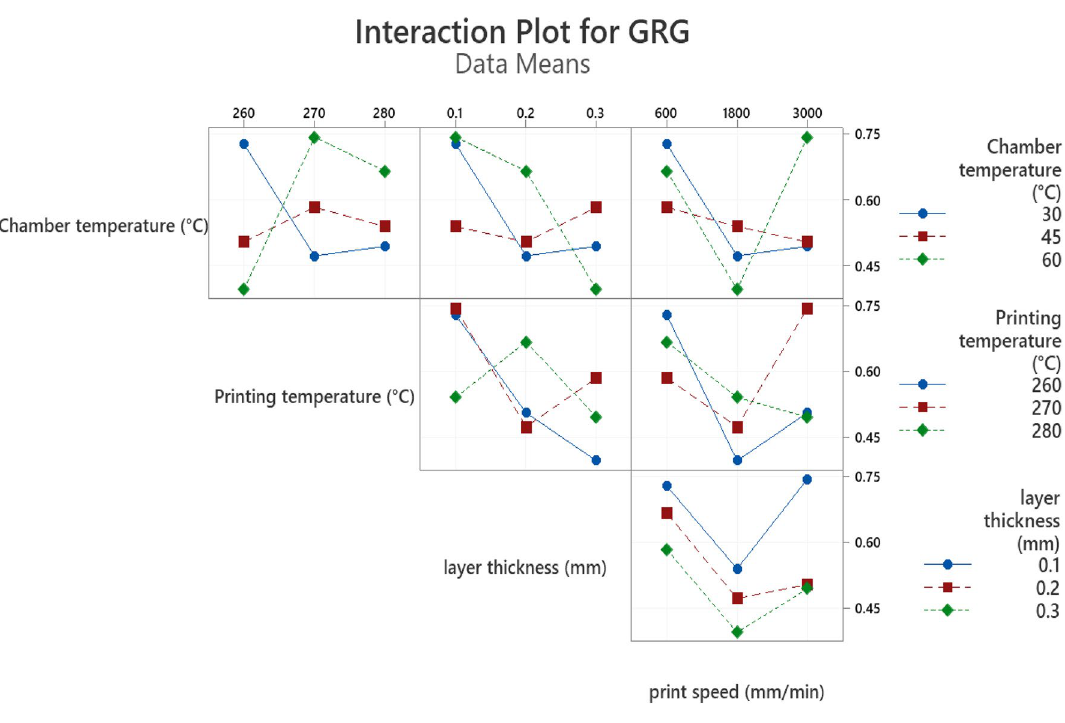
Figure 9. Interaction plots for